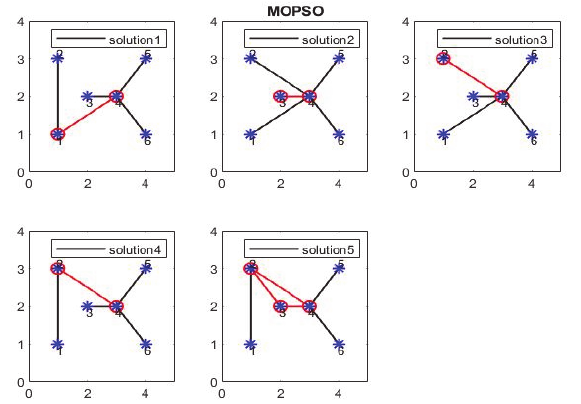
Fig. 10 . How to assign non-hub nodes to hub nodes in problem solving using the MOPSO algorithm